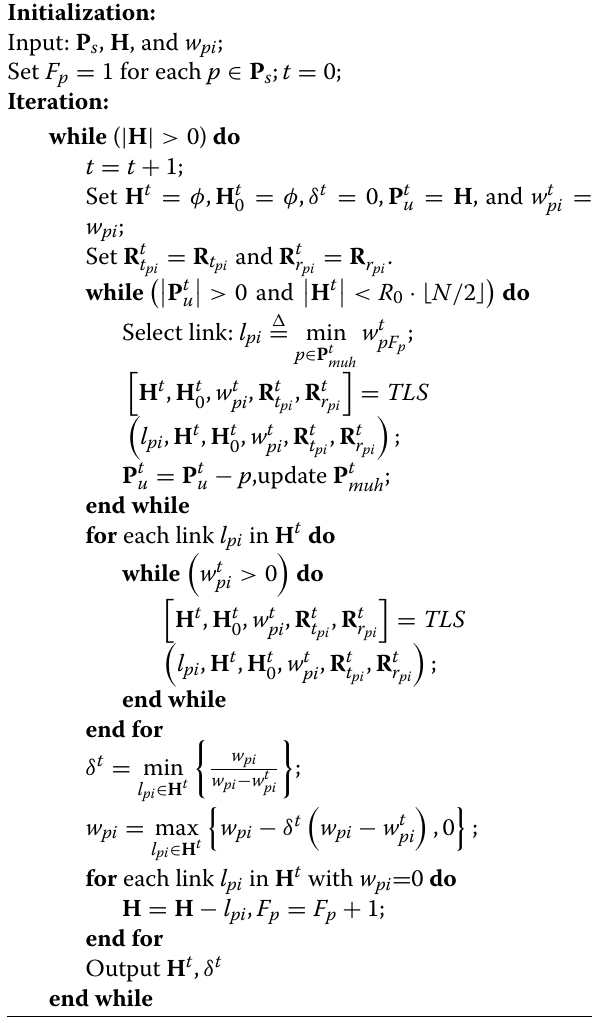
Algorithm 1 The transmission scheduling